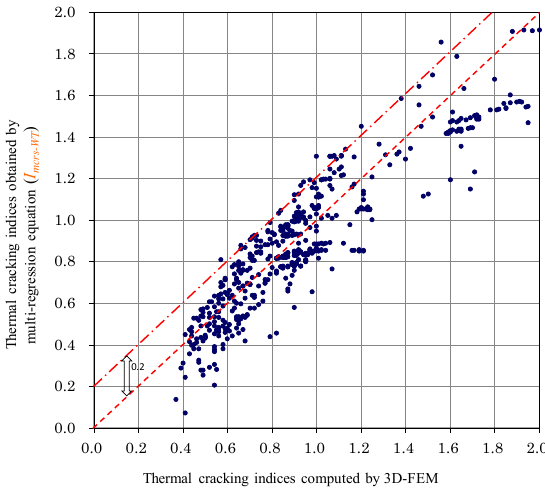
Figure 7. Relationship between the thermal cracking indexes of wall structures obtained by the multi-regression equation and those obtained by the 3D FEM